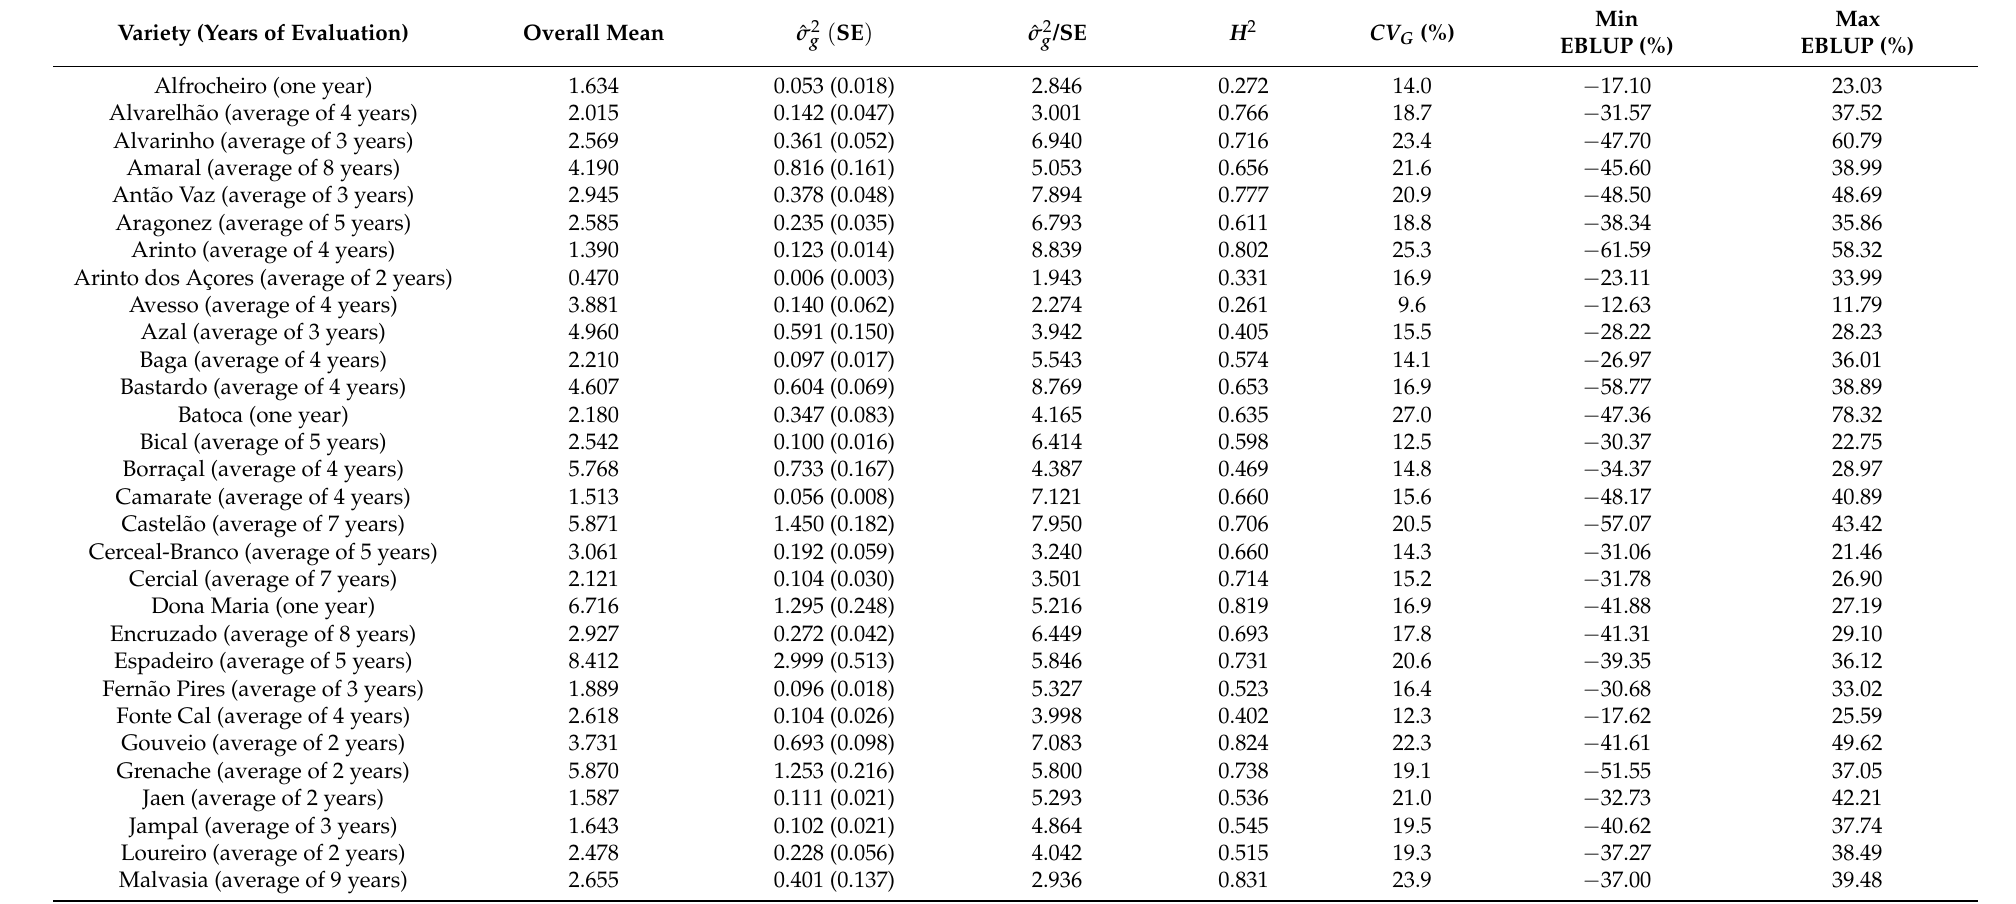
Table 3. Quantification of intra-varietal diversity of the yield in 59 varieties in Portugal (overall yield mean of the field trial (kg/plant); ˆ σ 2 g is the estimate of the genotypic variance of the yield and SE is the standard error associated to this estimate; the ratio ˆ σ 2 g /SE; broad-sense heritability ( H 2 ); genotypic coefficient of variation, in percentage ( CV G ); minimum and maximum empirical best linear unbiased predictors (EBLUPs) of the genotypic effects expressed as the percentage of the mean of the population (MinEBLUP and MaxEBLUP,